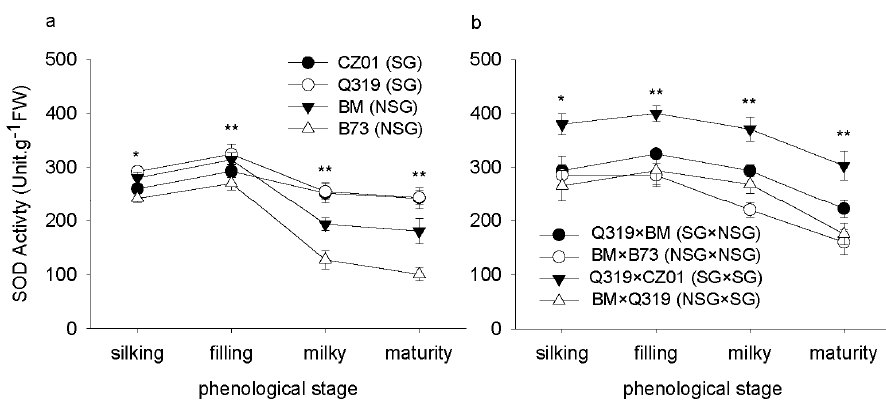
Figure 1. Superoxide dismutase (SOD) activity in ear leaves from different maize genetic backgrounds after silking. Values are means ± standard deviation ( n = 3). * indicates a significant difference between treatments at p < 0.05. ** indicates a significant difference between treatments at p < 0.01. ( a ) represents inbred lines, ( b ) represents hybrids. SG1 and SG2 are two types of maize for a higher stay-green ratio; CZ01, Q319, BM, B73 are the names of maize varieties.